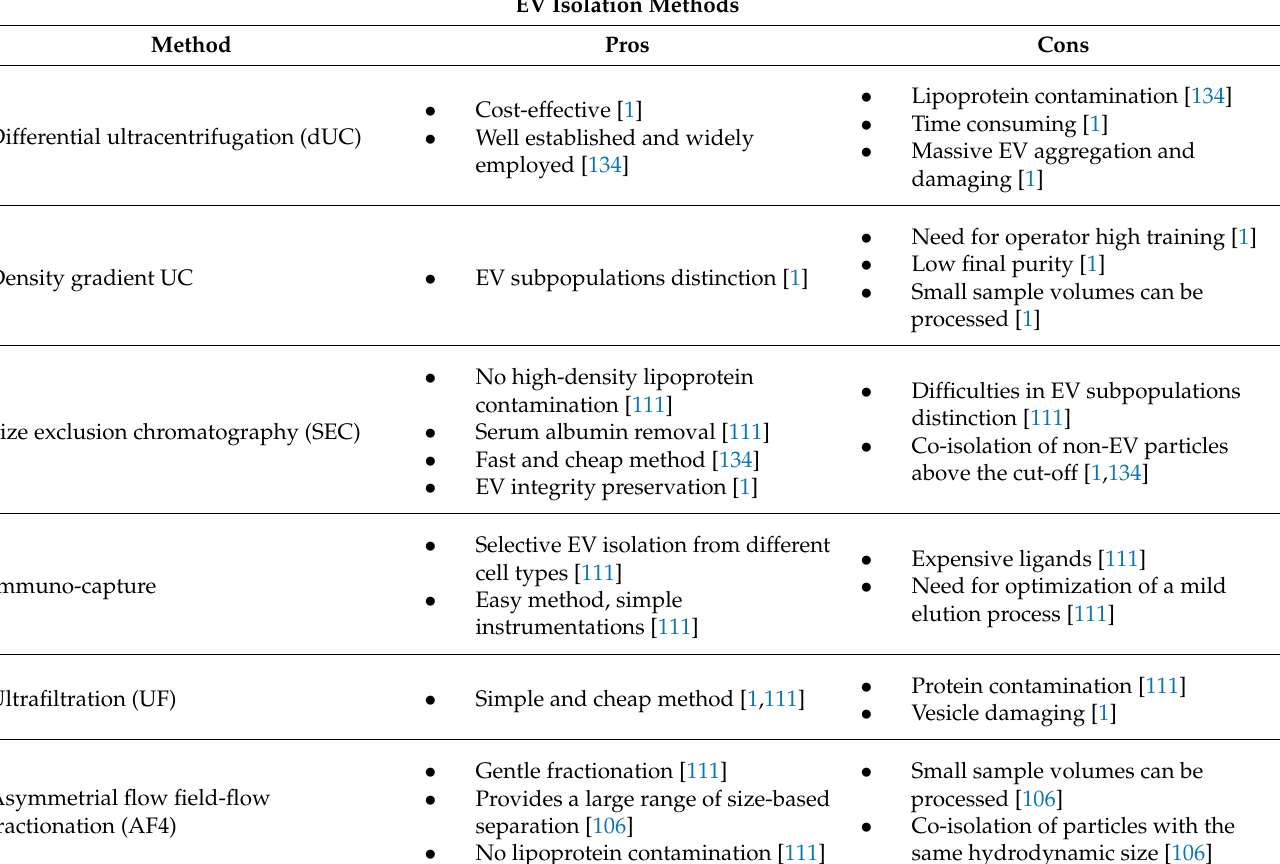
Table 1. Pros and cons overview of principal EV isolation